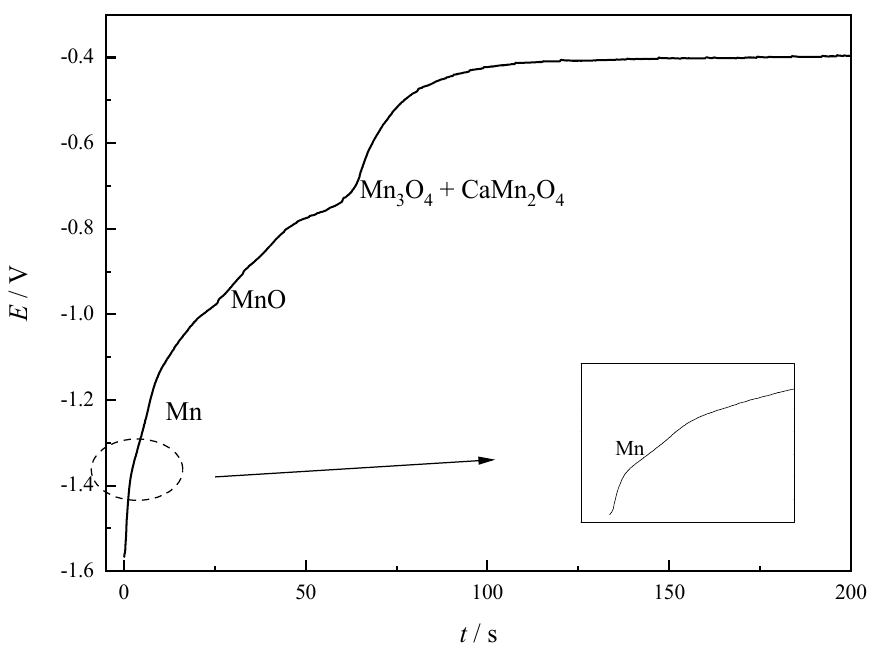
Figure 4. Open–circuit potentiometry on Pt electrode in NaCl–CaCl 2 –LiMn 2 O 4 . Measured the cyclic voltammetry curve of NaCl-CaCl 2 molten salt at 750 °C first, add lithium manganate (LiMn 2 O 4 ) for 1 h, and then performed cyclic voltammetry again. Analyzed the electrochemical reduction process of manganese on the surface of the Pt electrode. As shown in the dashed line in Figure 5.